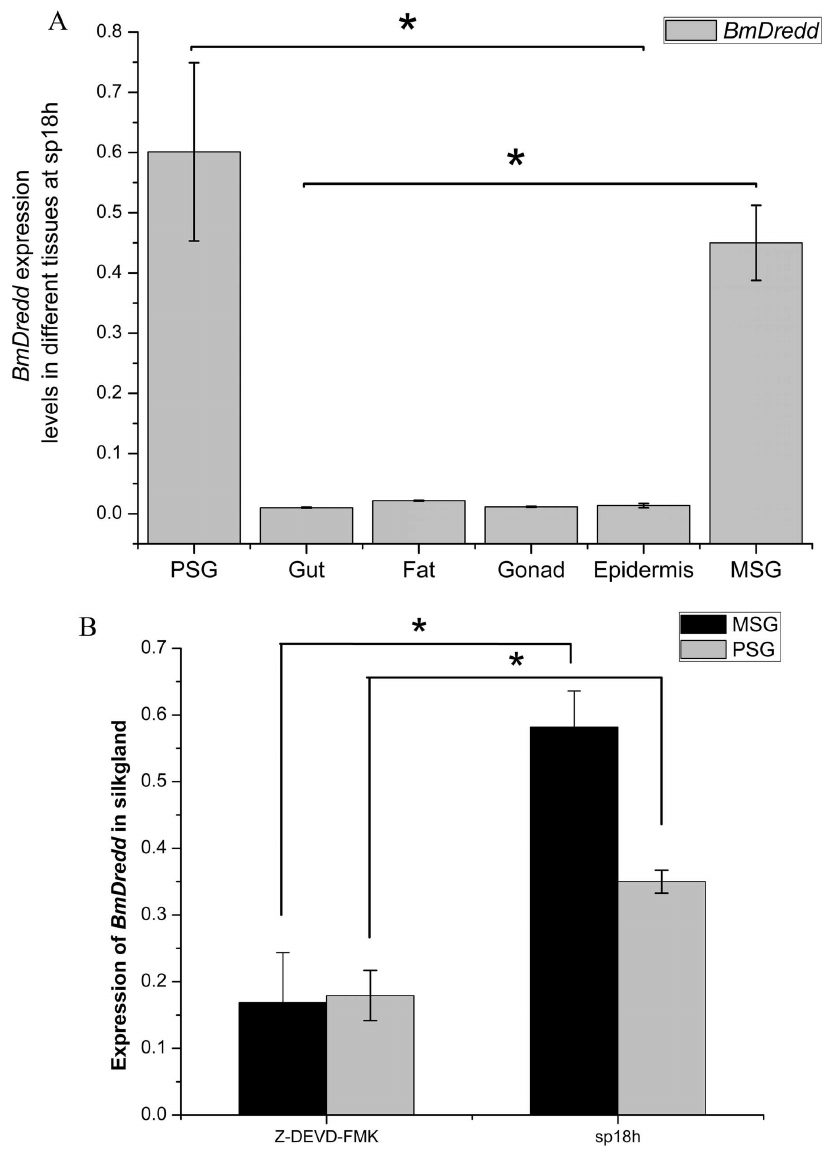
Fig 2. Role of BmDredd in SG apoptosis. (A) BmDredd expressionlevels in different silkwormtissues at sp18h, P < 0.05.(B) BmDredd expressionlevels in SG after injectingZ-DEVD-fmk for about 36 h, P <